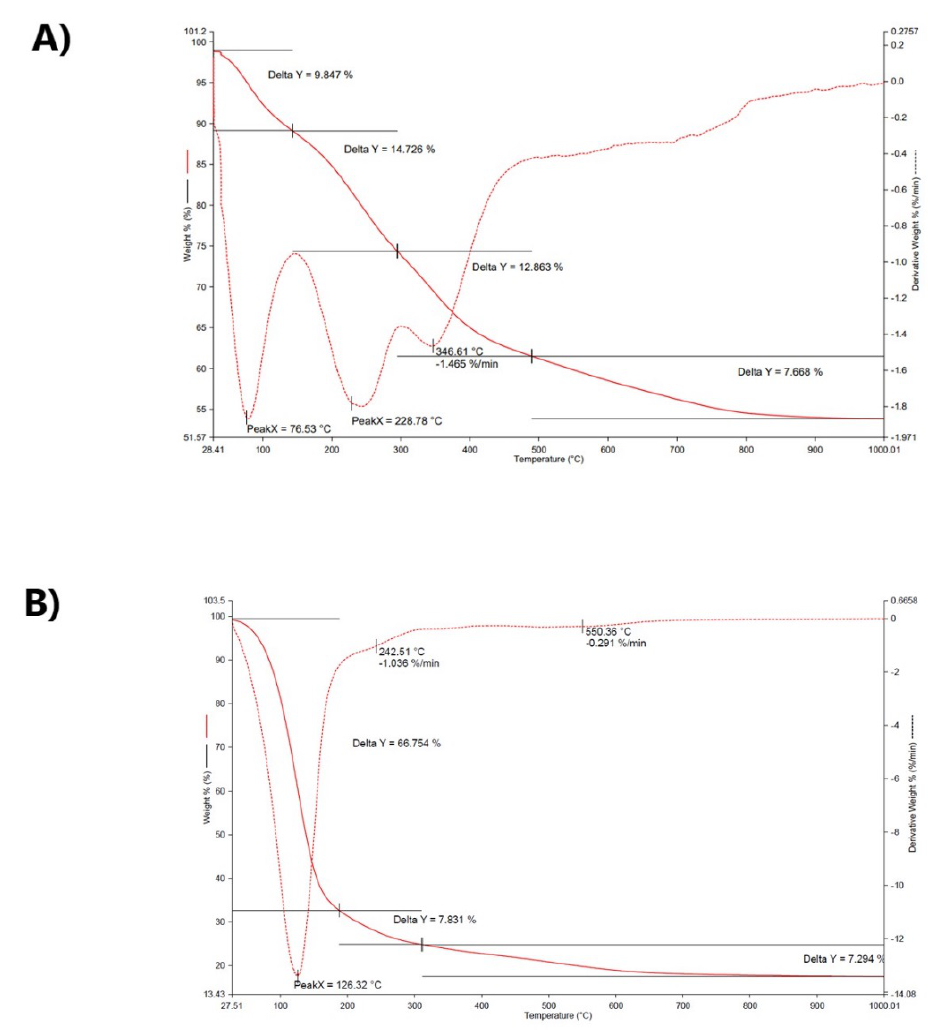
Figure 4. The TG of 2-chloro-2-propen-1-ol oligomers obtained using ( A ) [VO(dipic)(dmbipy)] · 2 H 2 O and ( B ) [VOO(dipic)](2-phepyH) · H 2